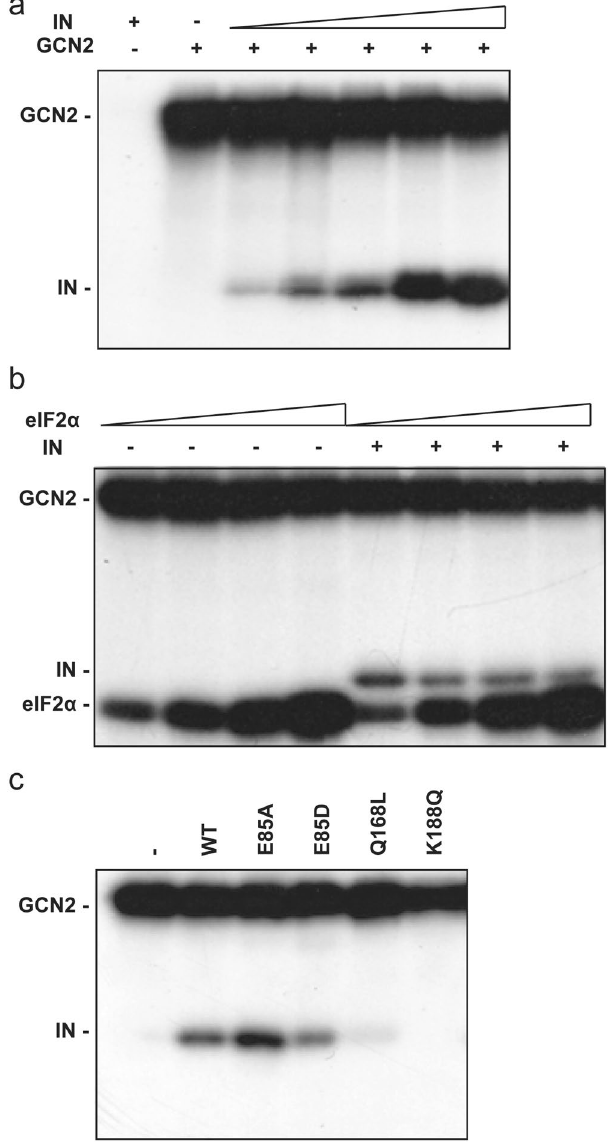
Figure 2. GCN2 in vitro phosphorylation assay. ( a ) Phosphorylation of HIV-1 IN catalyzed by GCN2. Lane 1, HIV-1 IN (2000 nM) alone. Lane 2 to 7, GCN2 (24 nM) was incubated with [ γ - 32 P]-ATP and increasing concentrations of HIV-1 IN (0, 100, 225, 450, 1000, 2000 nM). ( b ) Competition assay. GCN2 phosphorylation of increasing concentrations of eIF2 α (from 100 nM to 800 nM following a 2-fold increment) with radiolabeled [ γ - 32 P]-ATP, in the presence or not of HIV-1 IN (2 µ M). ( c ) Impact of HIV-1 IN oligomerization on phosphorylation by GCN2. Lane 1, no IN. Lanes 2 to 6, HIV-1 IN WT or mutants (700